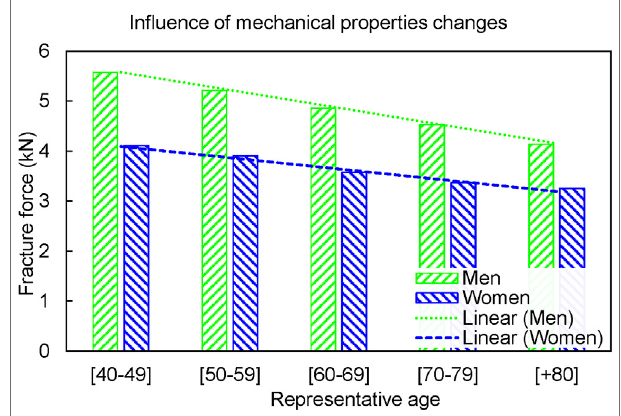
FIGURE 4 | The fracture forces in the MechAge set reduced by 354.5 N per decade for men and 225.4 N per decade for women.